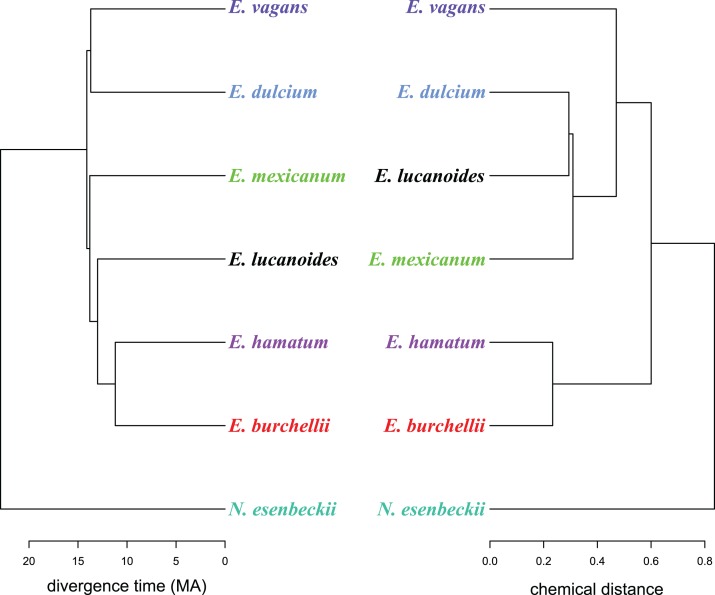
A chemo-evolutionary scenario of Eciton army ants.Dendrograms (based on unweighted averages) of species divergence times (extracted from Winston, Kronauer & Moreau, 2017) and chemical distances of mandibular gland secretions. Colors correspond to Fig. 1.